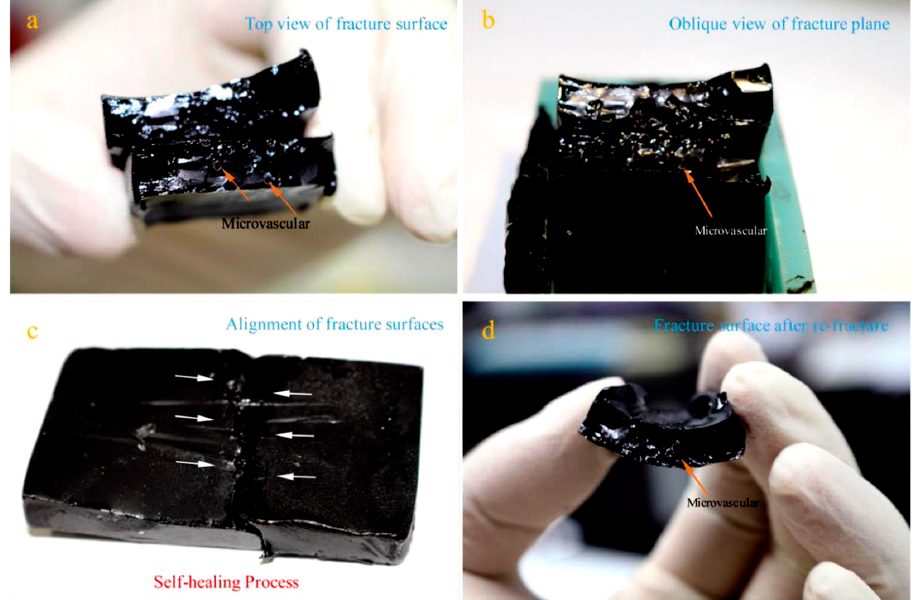
Figure 6. Photographs of the self-healing process of an asphalt/microvascular sample, ( a ) top view of the fracture surface of the asphalt sample, ( b ) oblique view of the fracture surface of the asphalt sample, ( c ) alignment of the fracture surface of the asphalt sample with a self-healing process for 3 days, and ( d ) the fracture surface of the re-fracture.